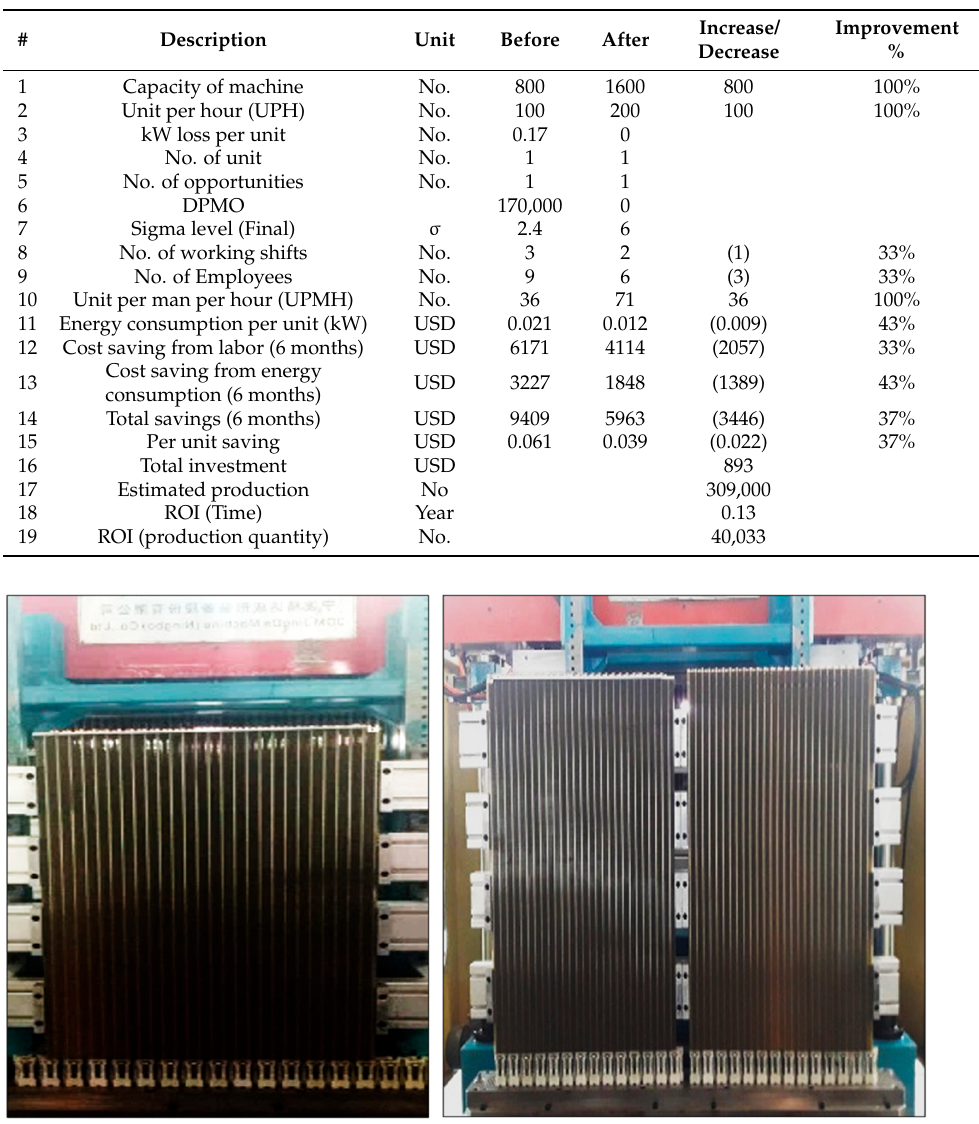
Table 10. Total saving.